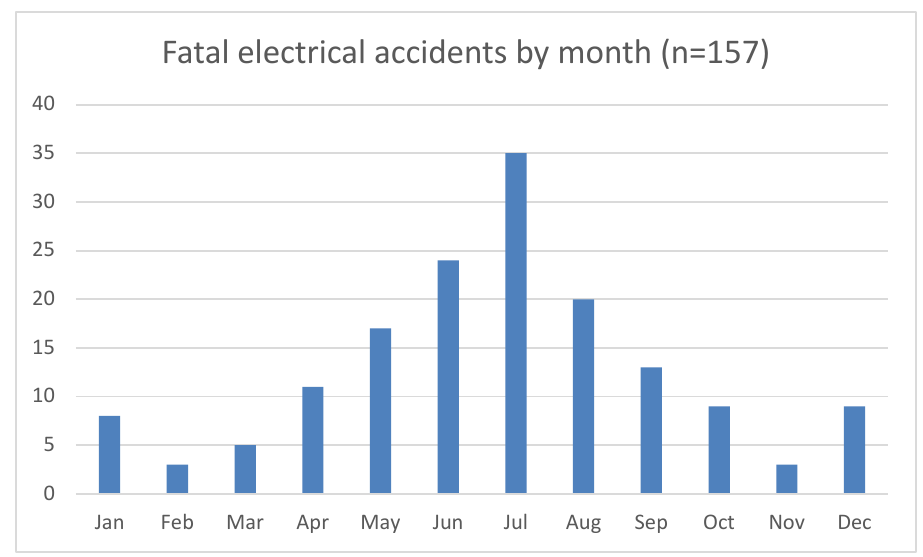
Figure 3. Monthly distribution of fatal electrical